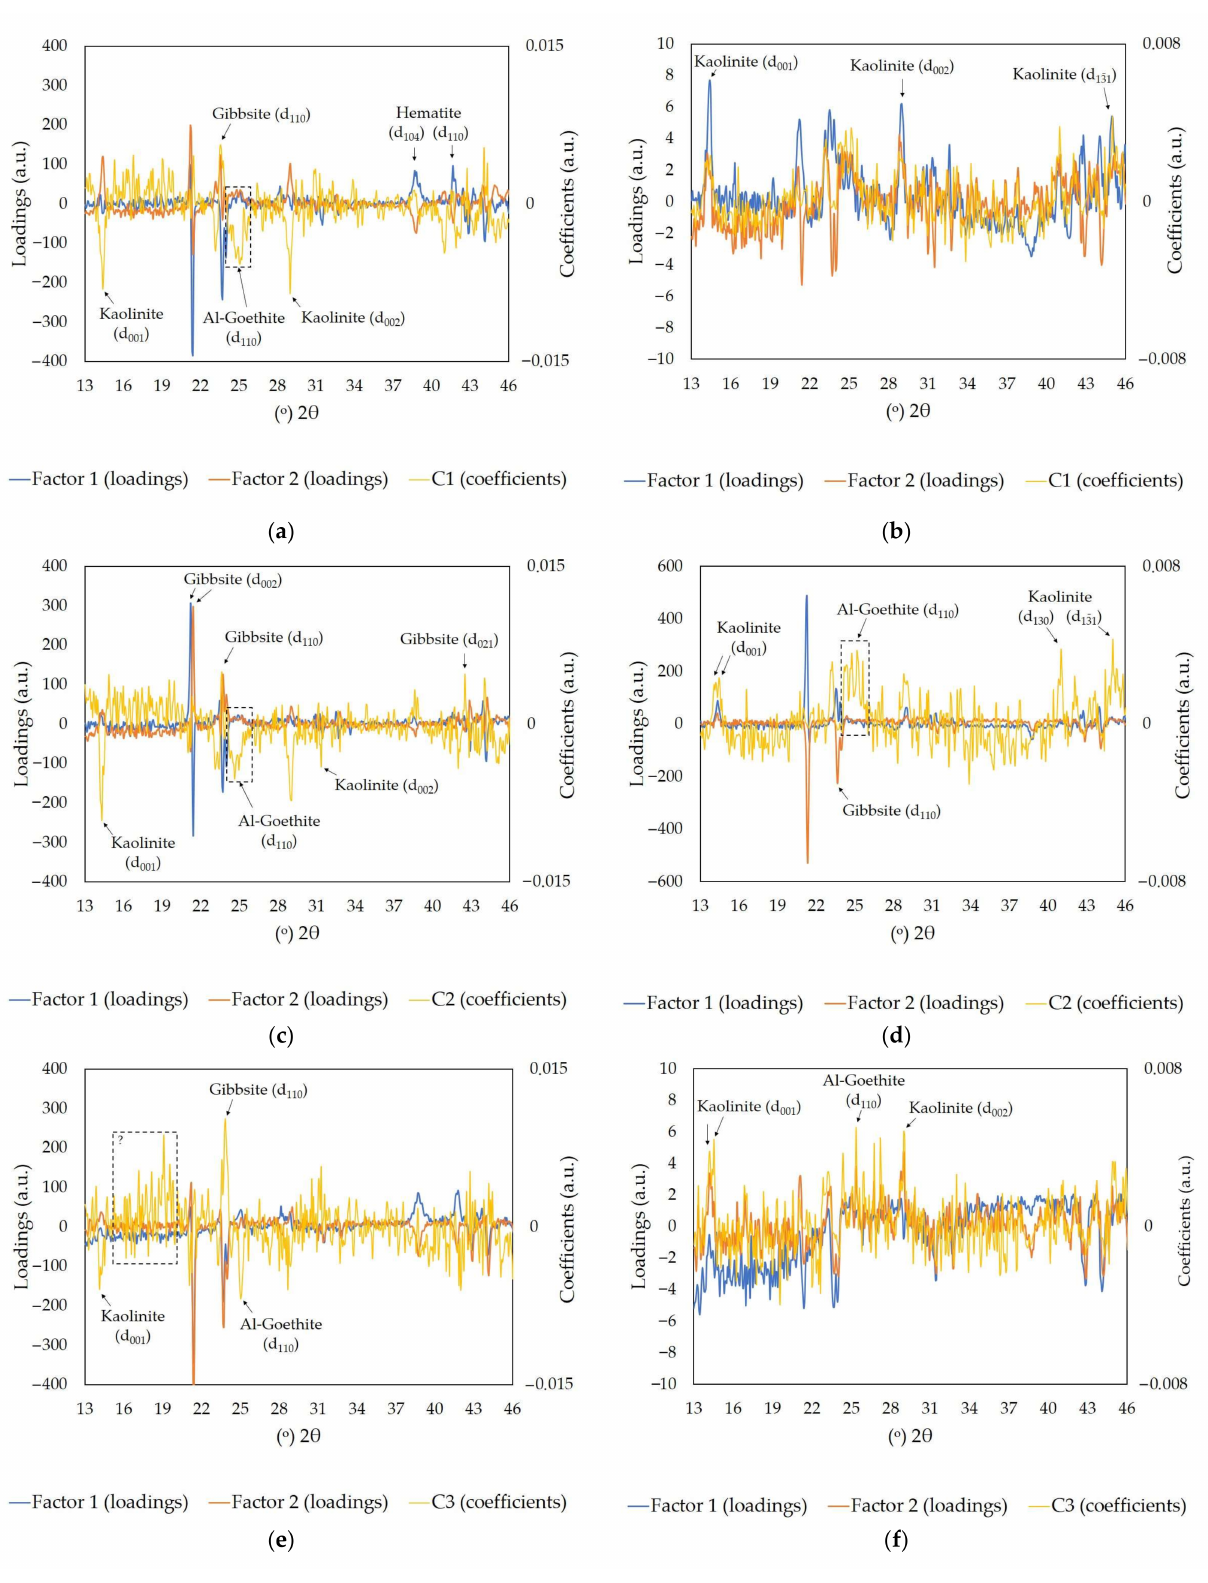
Figure 7. Linear representation of the coefficients and main factors of the models: ( a ) Av Al 2 O 3 (C1); ( b ) Rx SiO 2 (C1); ( c ) Av Al 2 O 3 (C2); ( d ) Rx SiO 2 (C2); ( e ) Av Al 2 O 3 (C3), and ( f ) Rx SiO 2